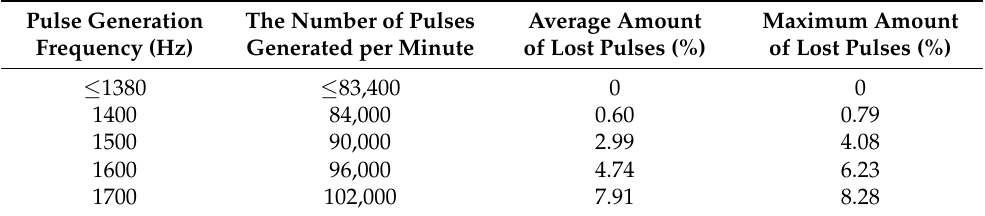
Table 1. The results of the AE pulse counting performance test by the monitoring system. Pulse